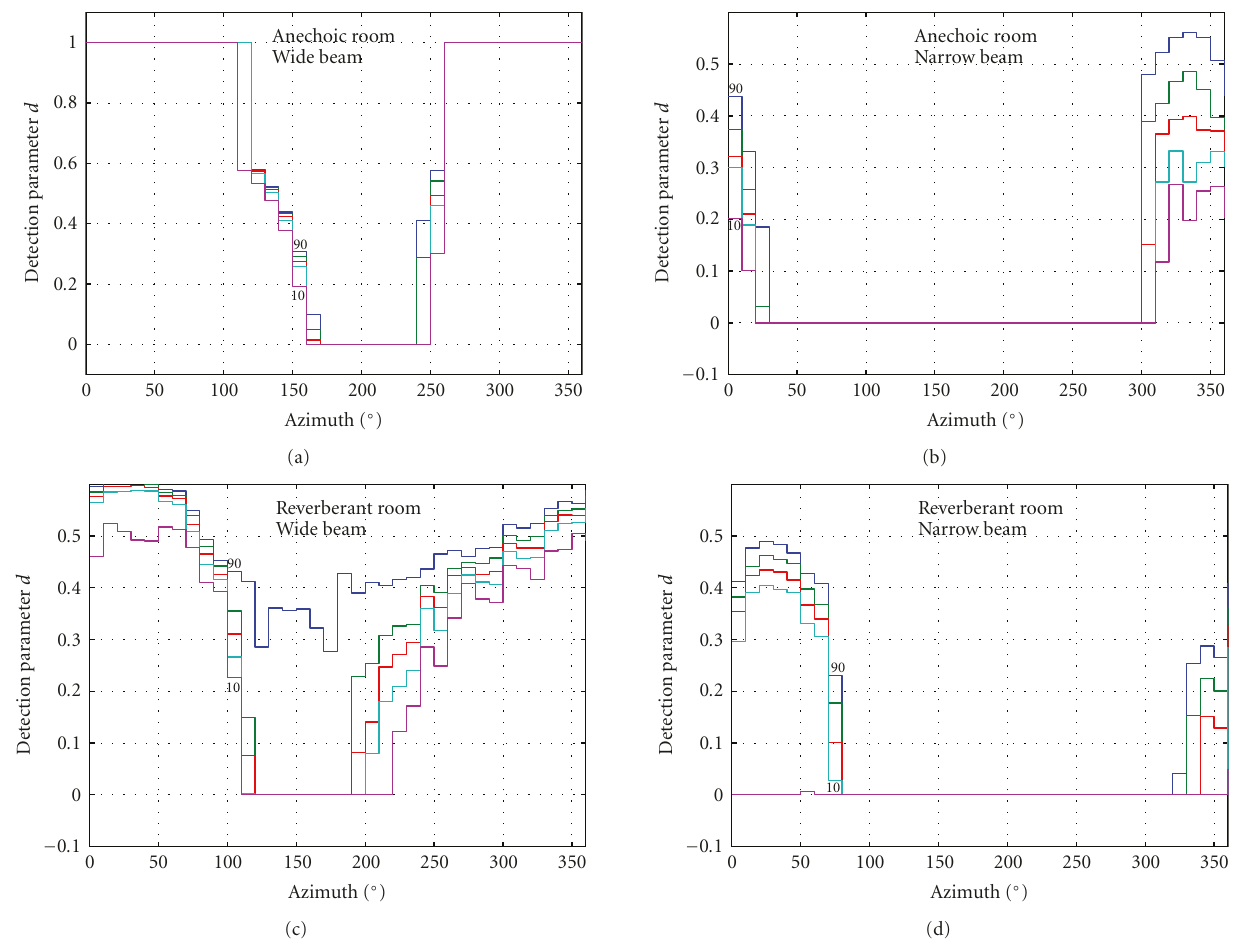
Figure 6: Wide beam (left hand panels) and narrow beam (right hand panels) system obtained with the multicorrelation algorithm with optional delays d S or d N (see also Figure 5), respectively.